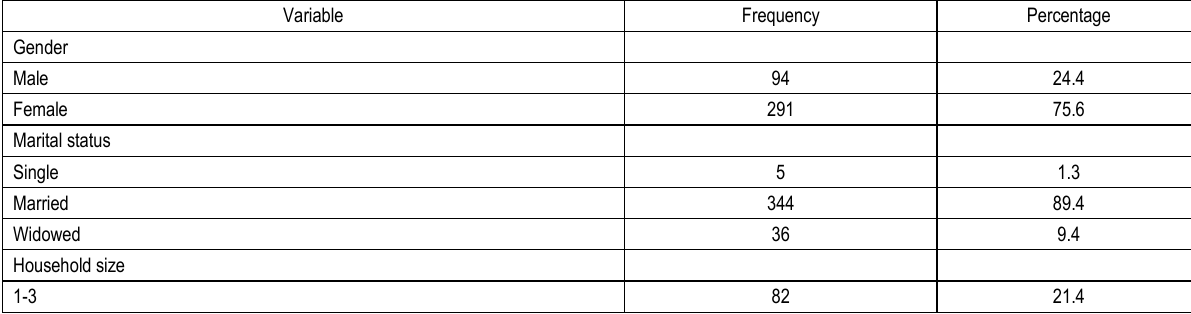
Table 2. Socioeconomic characteristics of